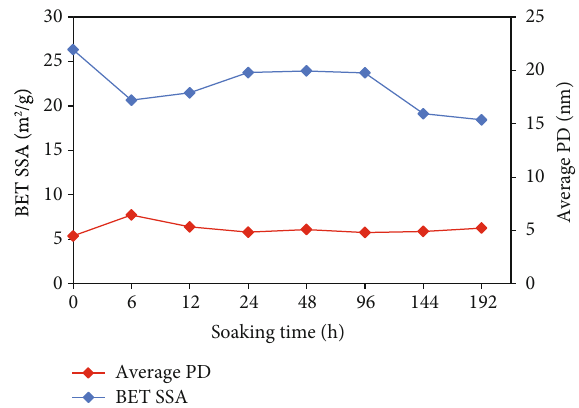
Figure 4: Change of nitrogen adsorption volume for di ff erent soaking times. Figure 5: Change in pore ratio SSA (m 2 /g) and average PD (nm) of the sample after soaking in slick